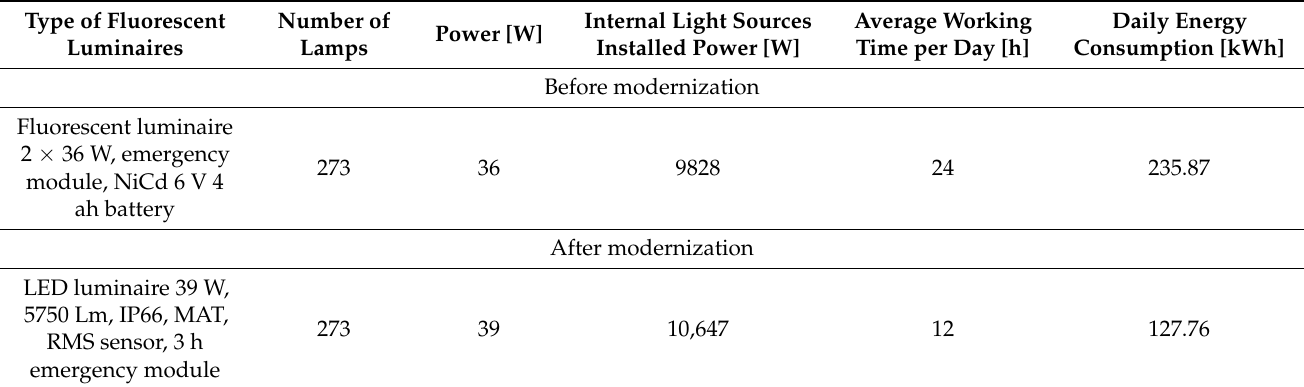
Table 1. The lighting of hotel staircases before and after